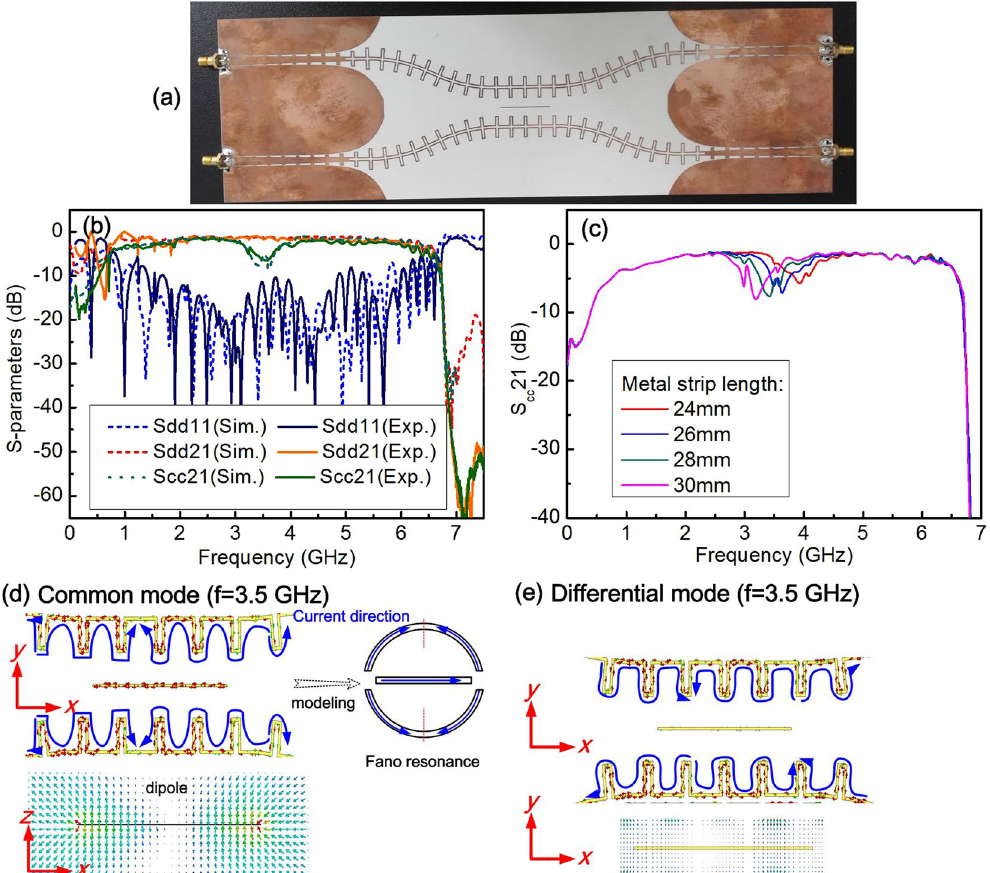
Figure 5. ( a ) The photo of the prototype sample. (b) Comparisons of simulated S-parameters with experimental results for differential mode and common mode. (c) Shift of the common mode rejection frequency with metal-strip length. (d) The current flowing on the strip and SPPs T-lines, and the Fano resonance like model for common mode suppression. (e) The current flowing on the strip and SPPs T-lines and electric field distribution around the strip in differential operation, which shows no resonance occurring in the central metal